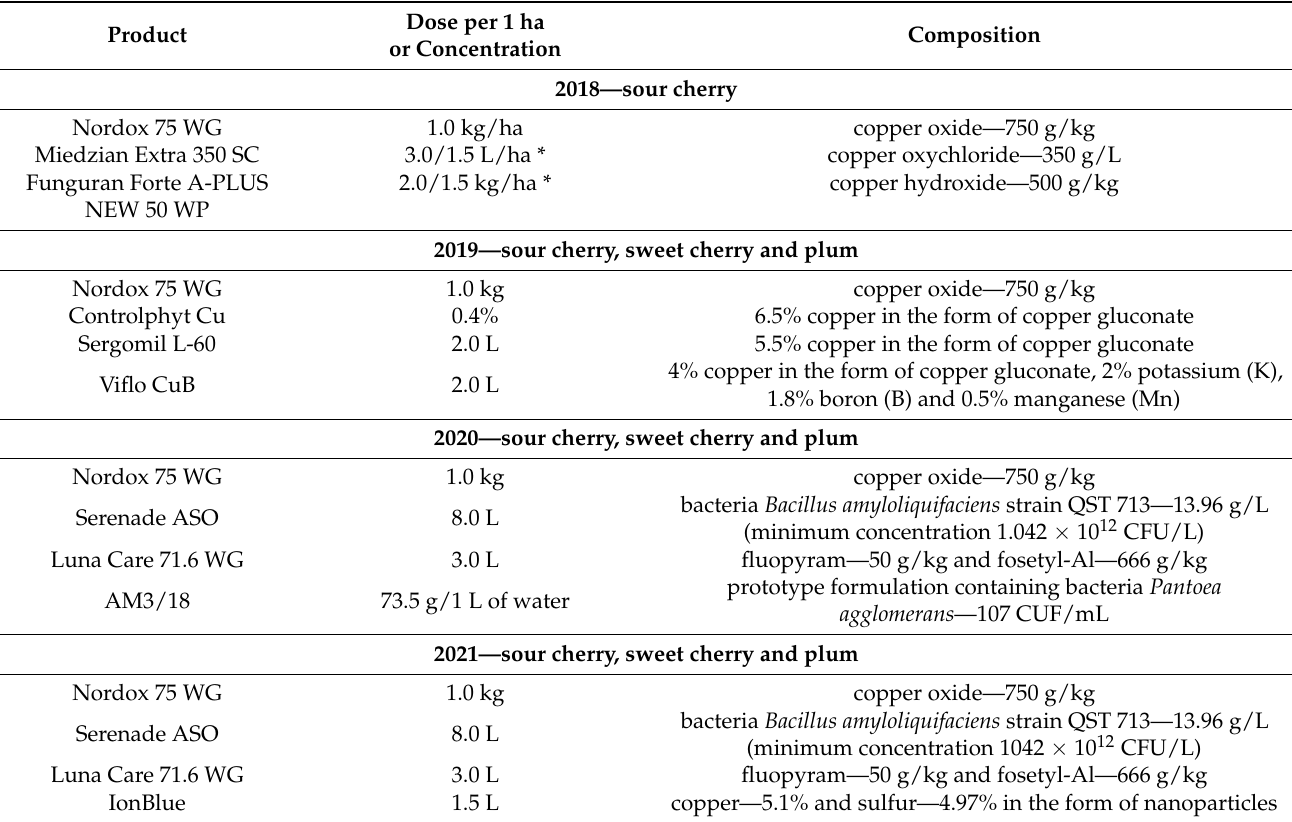
Table 1. Tested products and their doses and